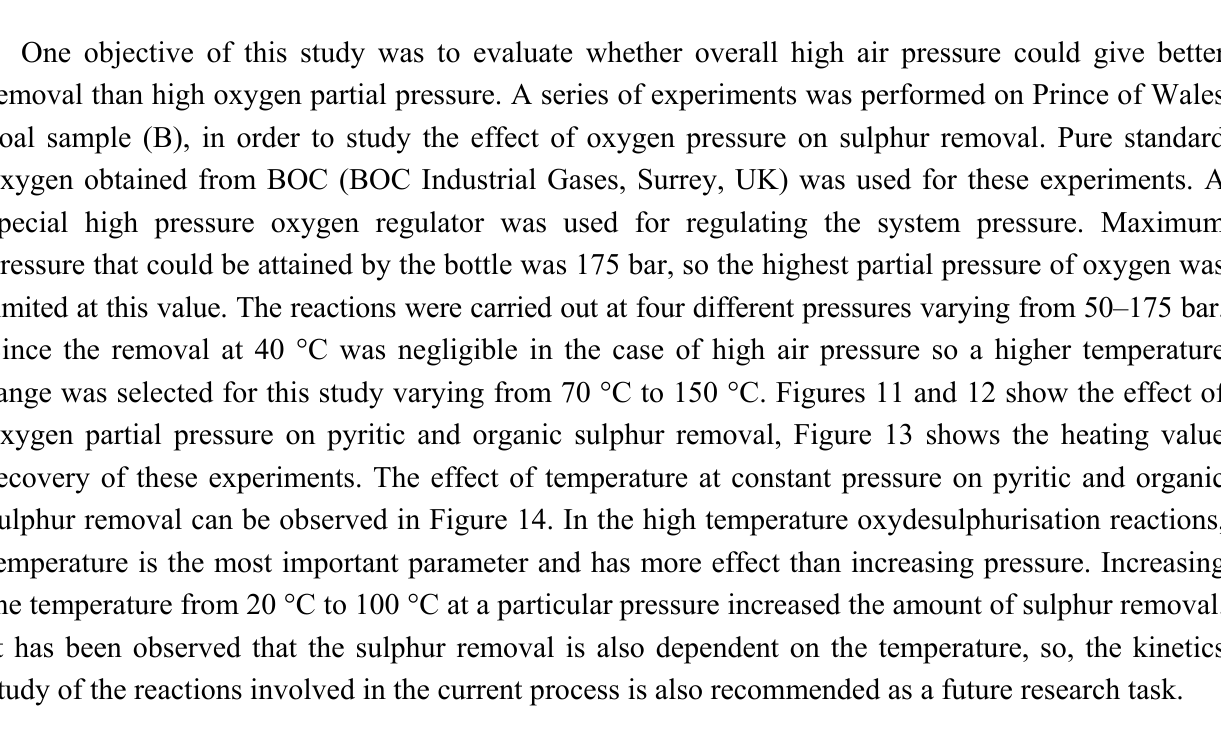
Figure 11. Effect of oxygen partial pressure on pyritic sulphur removal for Prince of Wales